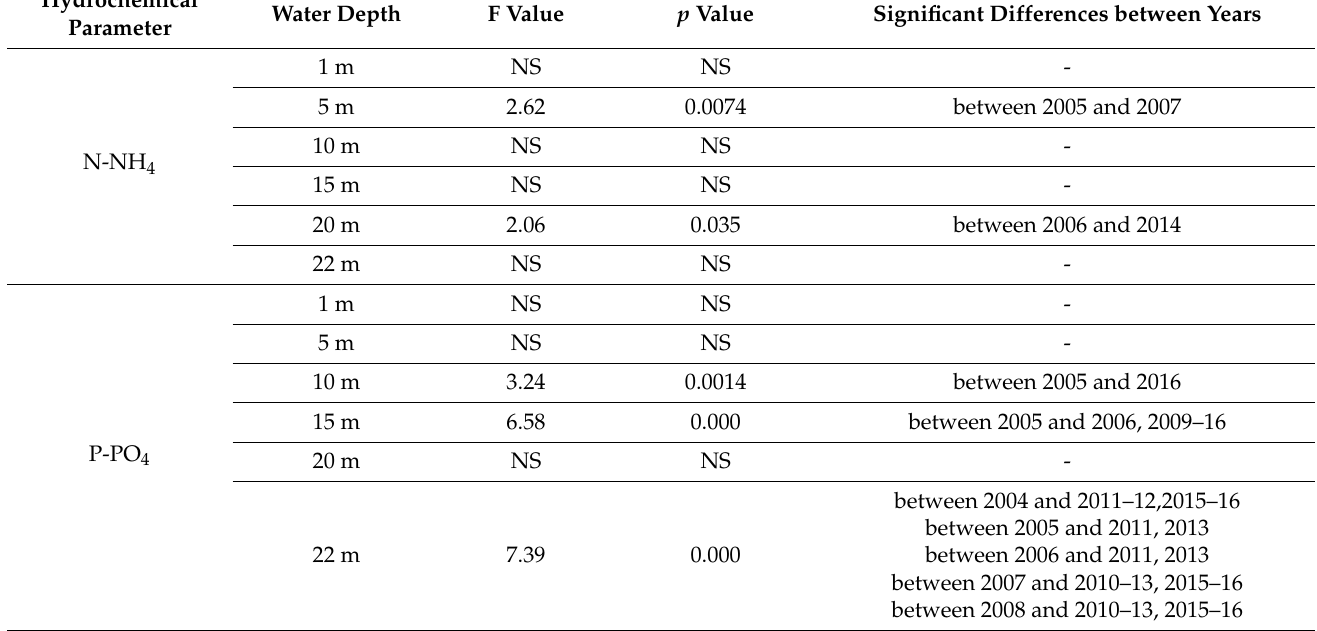
Table 5. Results of the one-way ANOVA analysis (effect df = 12, error df = 52) for the selected hydrochemical parameters of Starodworskie Lake water. Raw data were log transformed. Results above a significance level of 0.05 are marked as nonsignificant